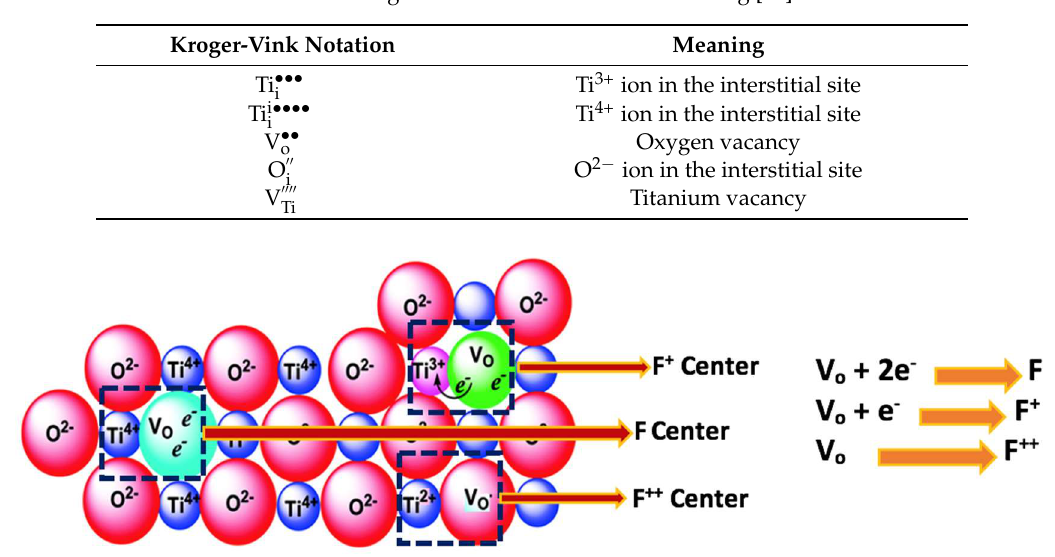
Table 2. Kroger-Vink notation and their meaning [47].